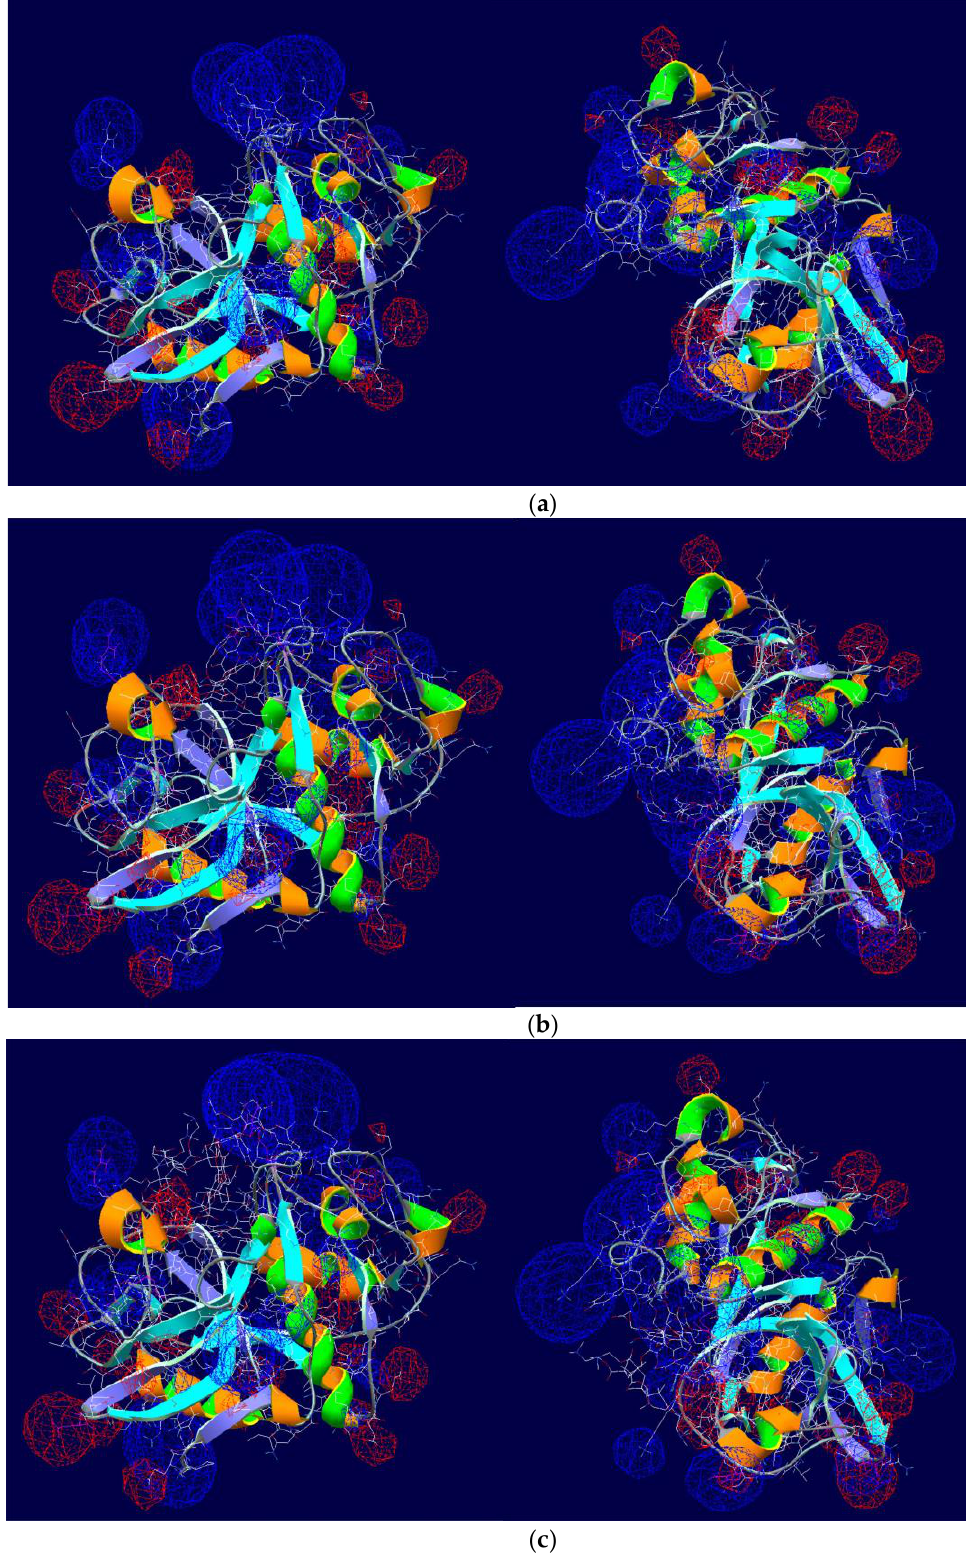
Figure 6. Surface electrostatic potential (in two projections) of ficin molecule ( a ) and complexes of ficin with Na-CMC ( b ) and Na-CMC- g -PDMAEMA ( c ): the domains of negative (positive) surface electrostatic potential values are given in red (blue).